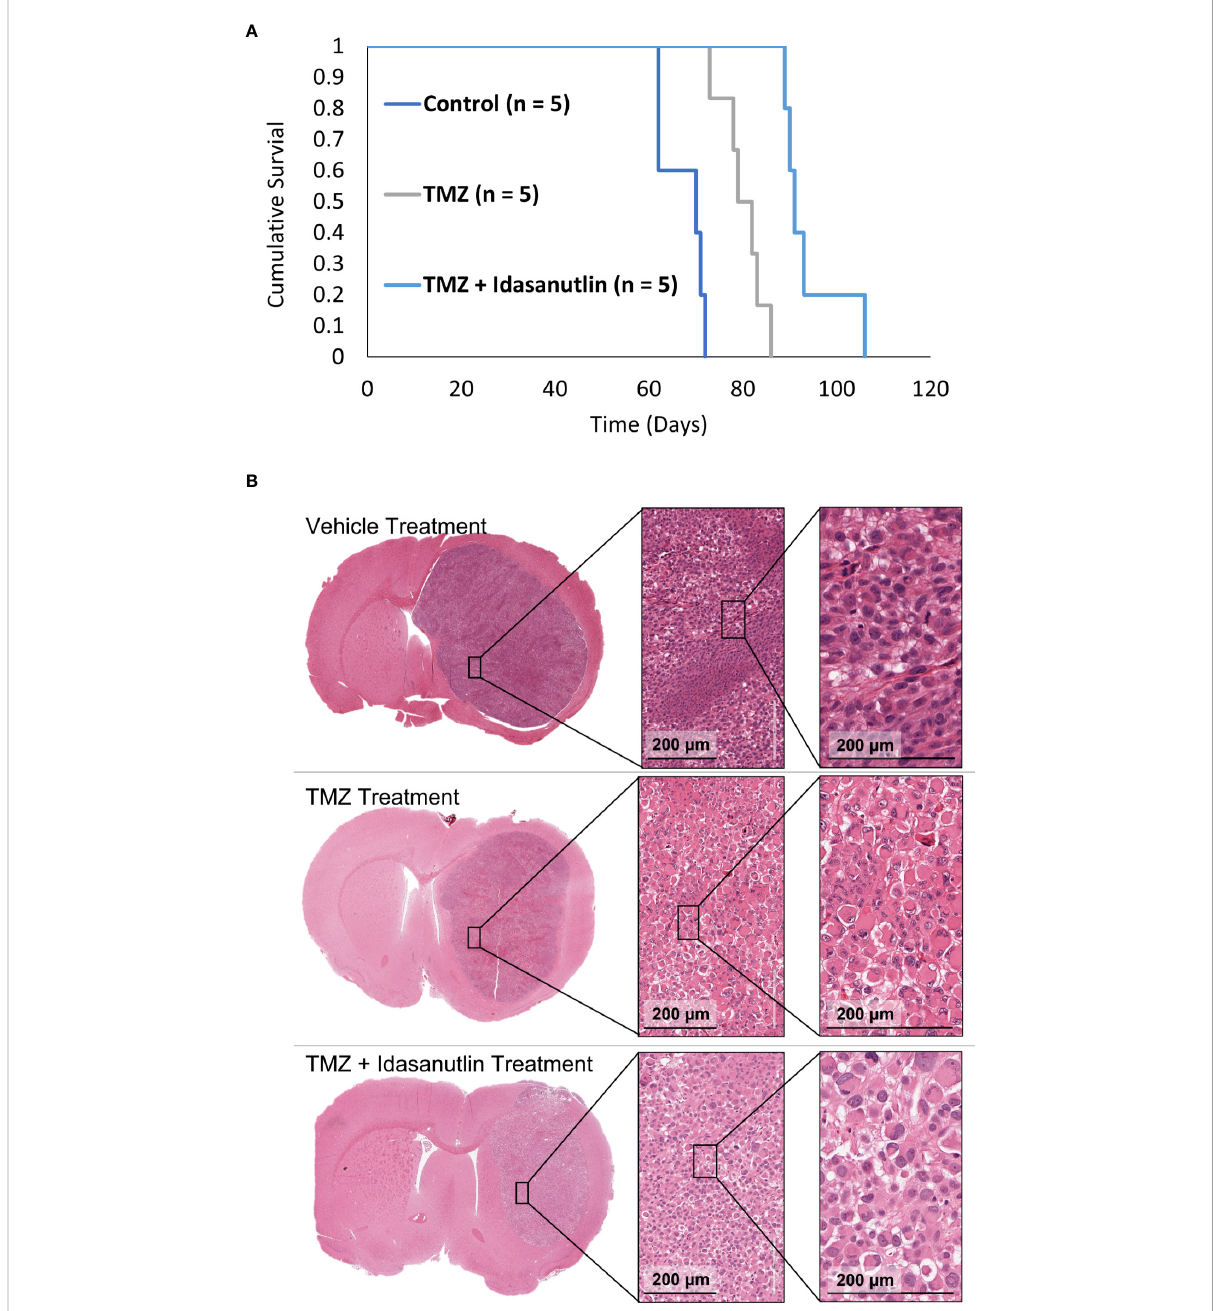
FIGURE 8 (Kaplan – Meier survival curves for control and chemotherapy-treated animals and Histological Characterization. (A) Cumulative survival was plotted against time for each group: control, TMZ-treated, and combination therapy-treated groups. The control (n = 5), TMZ-treated (n = 5), and TMZ + idasanutlin-treated (n = 5) rats implanted with GBM10 survived on average for 70, 79, and 91 days, respectively. Cumulative survival times differed signi fi cantly between groups (P < 0.001). (B) Top row: Coronal cross-section of the tumor of a representative control (vehicle- treated) rat, with higher-resolution images of a region within the tumor (inserts) showing high cellular density. Middle row: Coronal cross- section of the tumor of a representative TMZ-treated rat, with higher-resolution images of a region within the tumor (inserts) displaying intermediate cellular density and small pockets of cytoplasmic vacuolation. Although not widespread, this vacuolation was more frequent in the TMZ-treated group than in the control group. Bottom row: Coronal cross-section of the tumor of a representative TMZ + idasanutlin-treated rat, with higher-resolution images of a region within the tumor (inserts) showing low cellular density as well as large pockets of cytoplasmic vacuolation. Vacuolation was more consistently present in tumors of this treatment group, indicating a higher rate of apoptosis and necrosis in this group close to the experiment ’ s endpoint than in the control and TMZ-treated